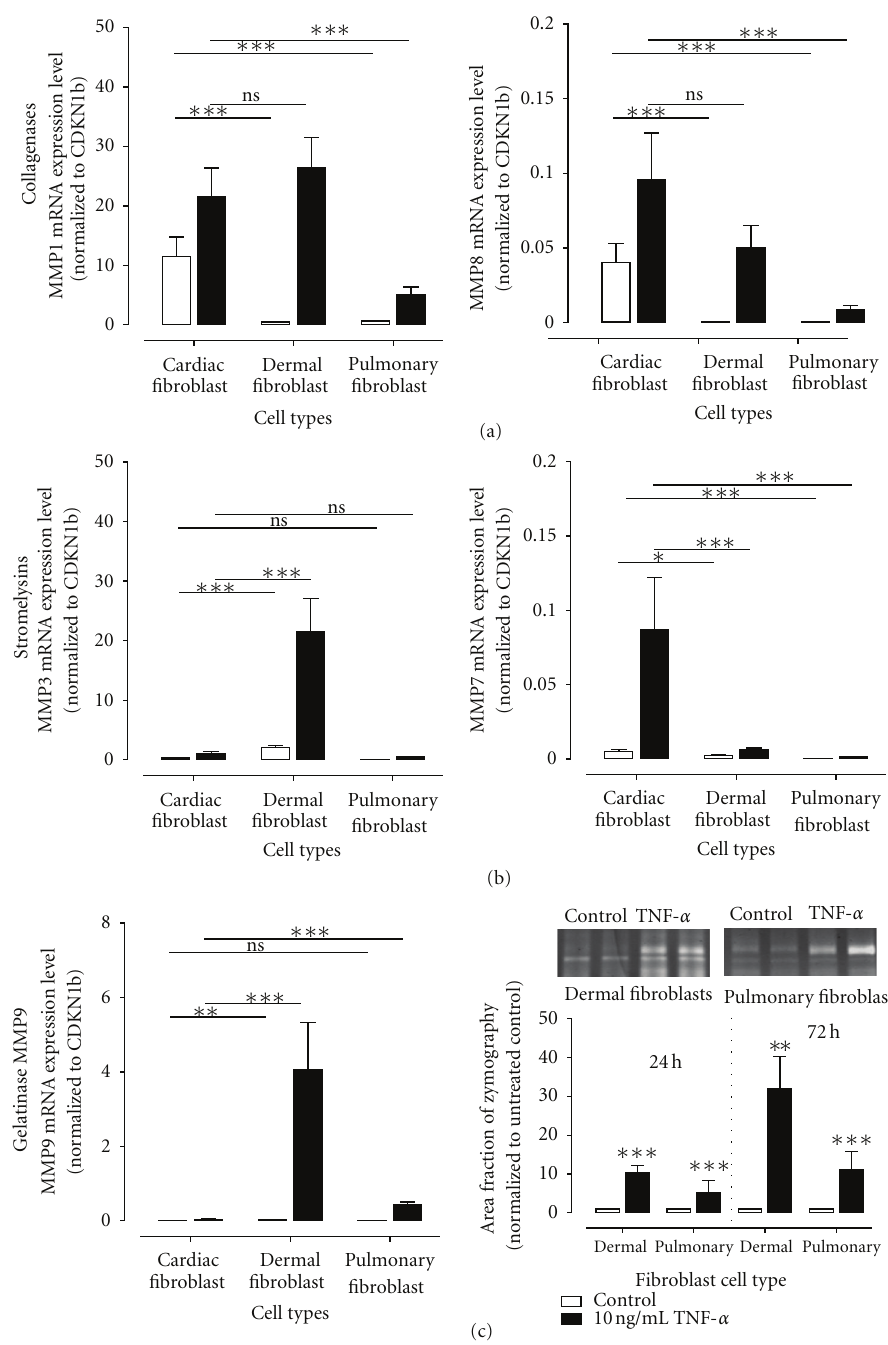
Figure 3: Alteration of MMP expression levels in cardiac, dermal, and pulmonary fibroblasts after treatment with 10 ng/mL TNF- α for 24 hours. Di ff erent alteration of collagenases (a), stromelysins (b), and MMP9 (c) expression levels after TNF- α treatment. MMP9 activity was further determined in the cell culture supernatant of cardiac, dermal, and pulmonary fibroblasts. Representative bands of MMP9 activity in dermal and pulmonary cell culture supernatants with or without TNF- α for 72 hours are shown. No MMP9 activity could be detected in cell culture supernatant of cardiac fibroblasts. All mRNA expression levels are shown as absolute expression using the formula 2 − Δ Ct